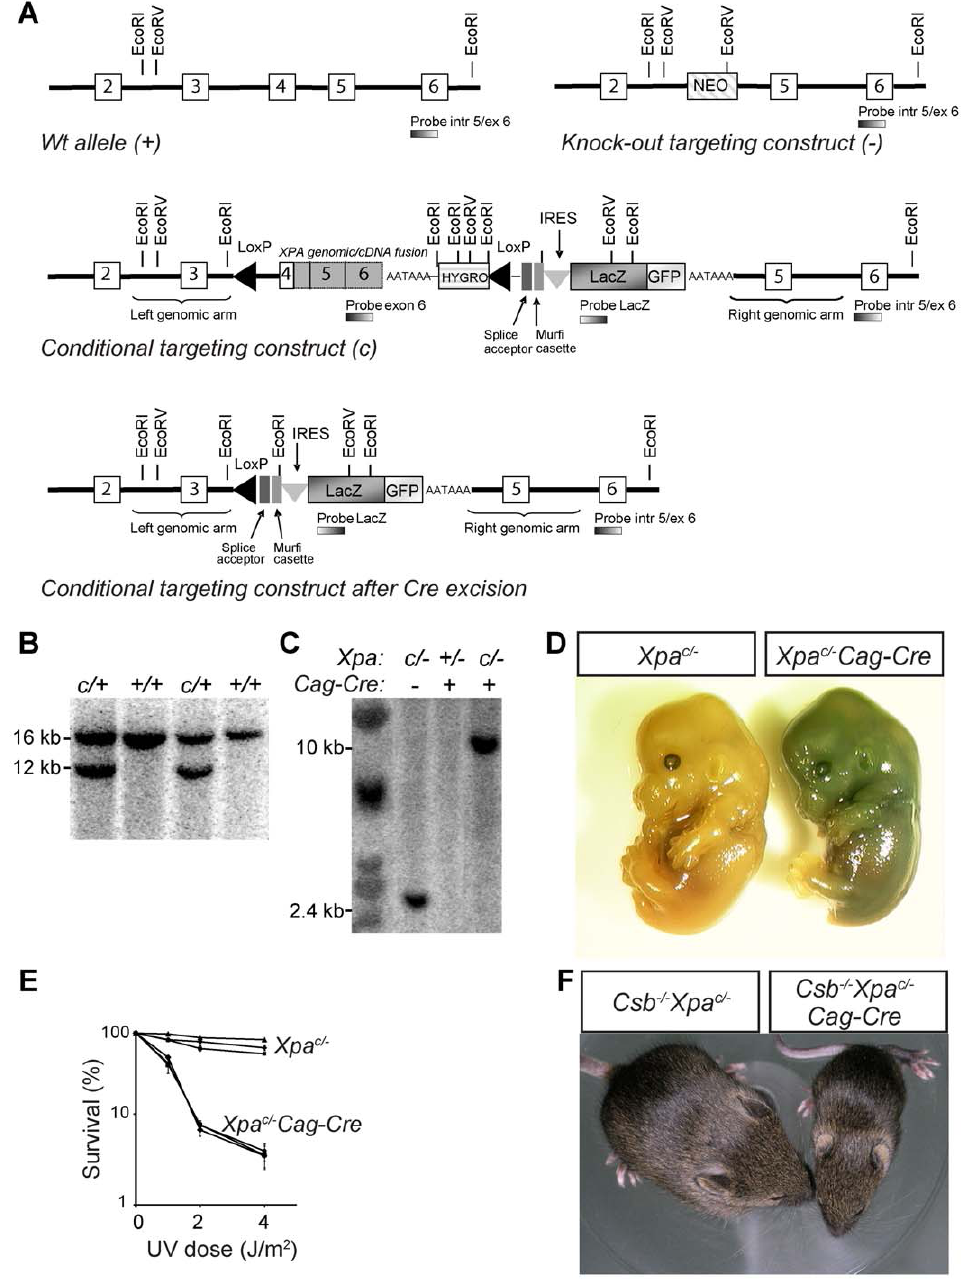
Figure 4. Generation of conditional Xpa c/ 2 mouse with a floxed genomic/cDNA fusion construct. A) Schematic representation of the wild-type mouse Xpa locus (exon 2 to 6), the targeting construct, the conditional Xpa allele, and the conditional Xpa allele following Cre-recombinase- mediated inactivation. In addition the knock out allele with a neomycin (NEO) marker cassette, as present in the non-conditional Xpa mouse model is shown [41]. In the conditional construct, exon 4 was fused in frame to the mouse Xpa cDNA (containing the remaining coding sequence and including a synthetic polyA sequence), followed by a PGK promoter-driven hygromycin (HYGRO) selectable marker gene. LoxP sites were introduced in intron 3 and downstream of the hygromycin marker to allow Cre-mediated excision of the cDNA and hygromycin marker gene, yielding an Xpa allele lacking exon 4, known to act as a null allele. A LacZ-GFP fusion marker gene, preceded by a splice acceptor (SA) and an internal ribosomal entry (IRES) was included to allow visualization of inactivation of the conditional Xpa allele. Open and gray boxes represent exon and cDNA sequences, respectively. The splice acceptor-Murfi cassette ensures proper splicing and translational stops in all frames respectively when the Xpa gene is knocked out. B) Southern analysis of wild-type ES cell DNA transfected with the conditional Xpa construct. DNA was digested with EcoRI and hybridized with an intron 5/exon 6 probe, external to the targeting construct. Wild-type and targeted alleles gave fragments of 16 and 12 kb, respectively. C) Southern blot analysis of DNA from E13.5 Xpa c/ 2 and Xpa c/ 2 / Cag-Cre embryos. DNA was digested with EcoRV and hybridized with a LacZ probe. Intact and Cre-inactivated conditional Xpa alleles are represented by 2.4 and 10 kb fragments, respectively. D) LacZ staining of E13.5 Xpa c/ 2 and Xpa c/ 2 / Cag-Cre embryos, indicating inactivation of the conditional Xpa allele in Xpa c/ 2 / Cag-Cre embryos only. E) Survival of wild-type, Xpa c/ 2 and Xpa c/ 2 / Cag-Cre MEFs, exposed to increasing doses of UV-C light. F) Photograph of 16-day old Csb 2 / 2 / Xpa c/ 2 and Csb 2 / 2 / Xpa c/ 2 / Cag-Cre littermates, the latter showing severely reduced